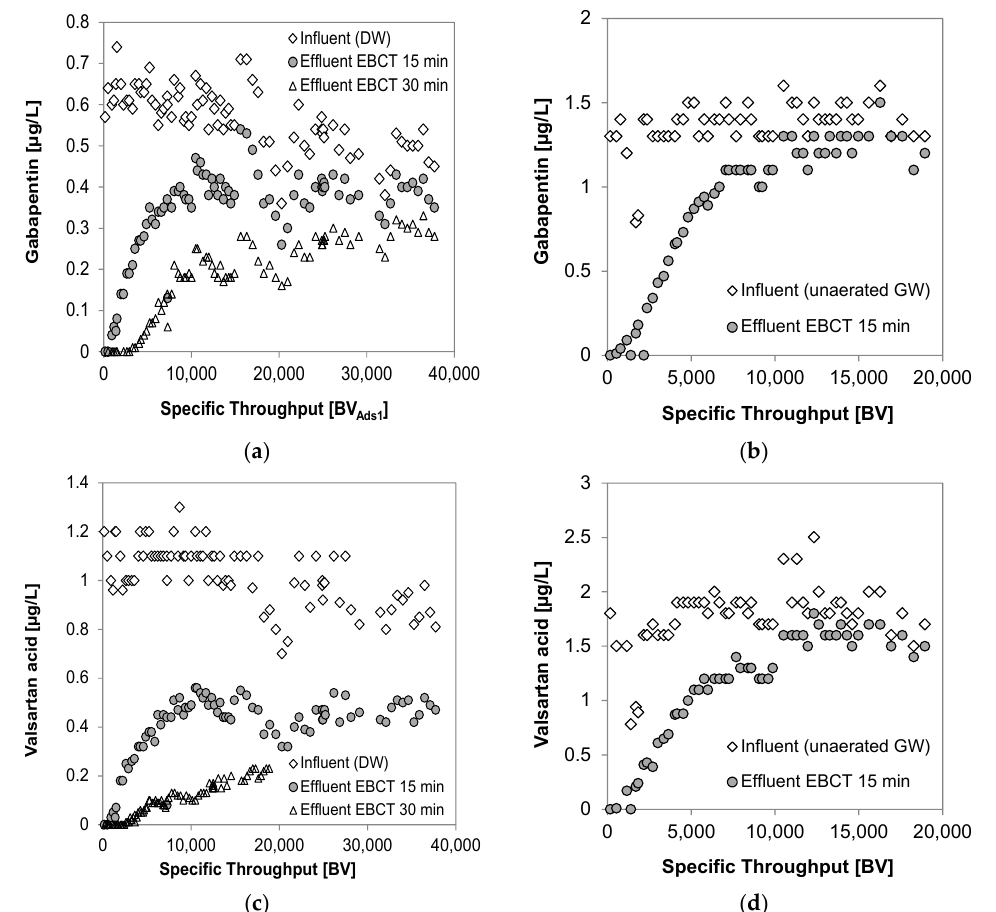
Figure 6. Breakthrough curves for ( a , b ) gabapentin and ( c , d ) valsartan acid in two fixed-bed adsorbers in series fed with drinking water (left) and a single fixed-bed adsorber fed with unaerated groundwater (right).